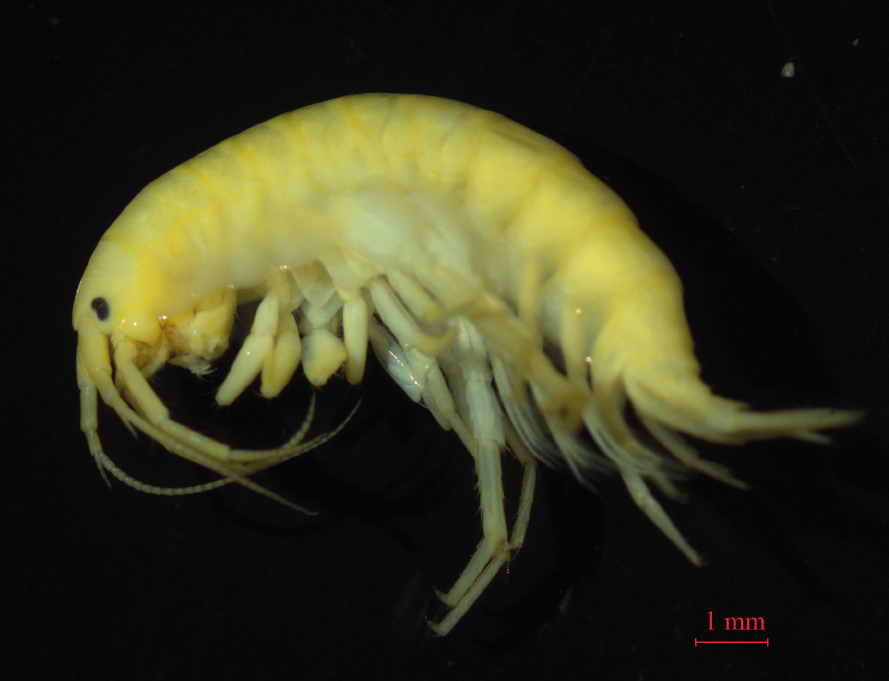
Figure 4. Gammarus zhouqiongi sp. nov.,